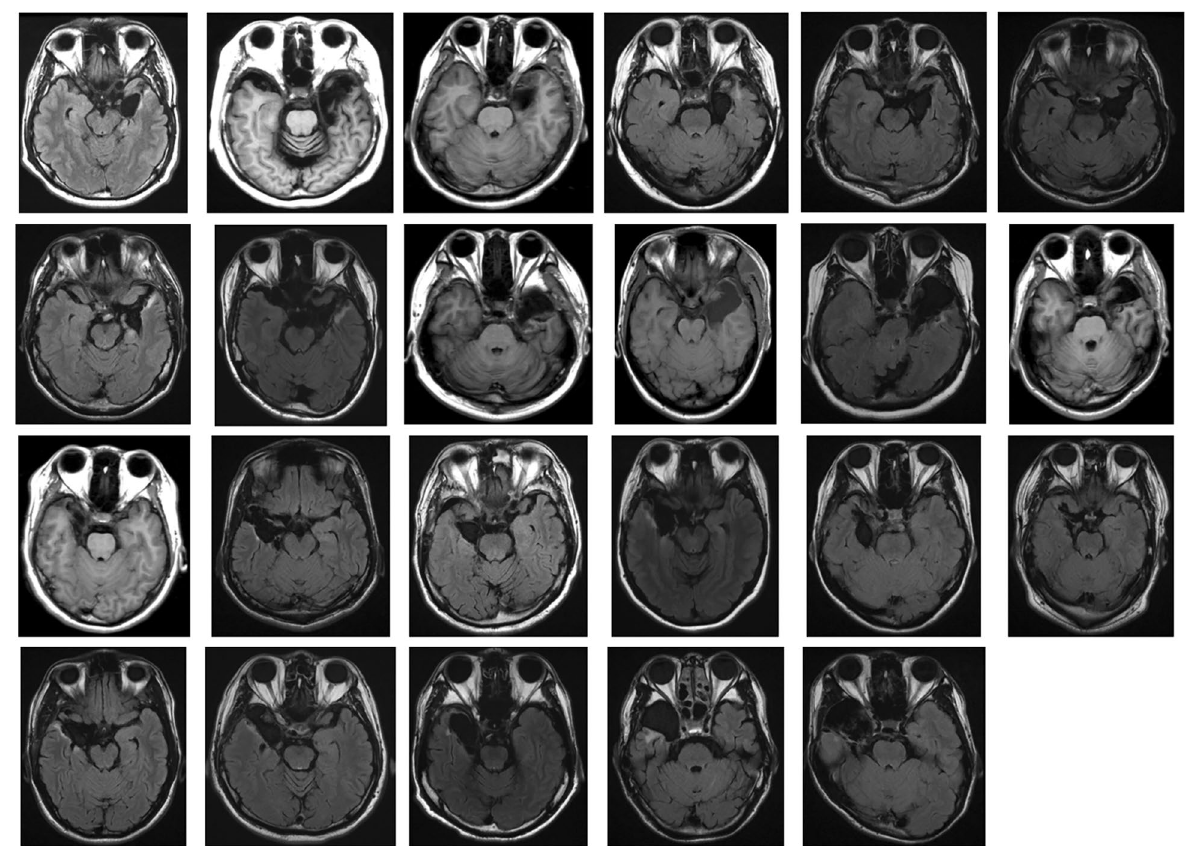
Figure 1. Anatomical magnetic resonance images of the temporal-lobe-resected patients. Left is shown on the right in the images.